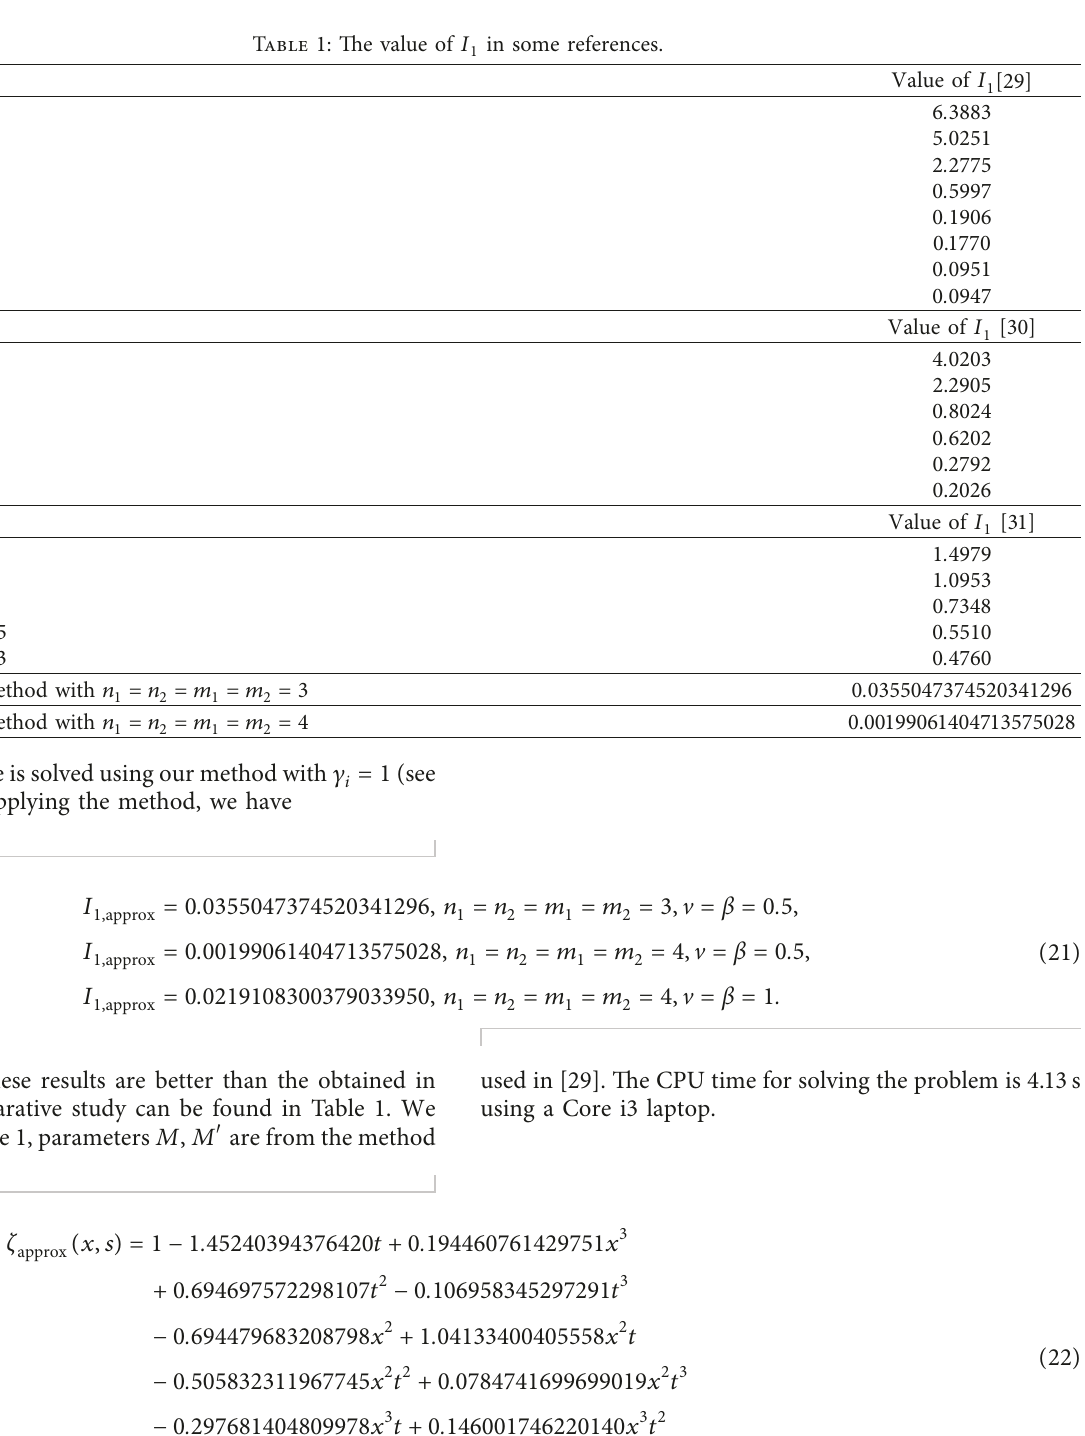
Table 1: The value of I